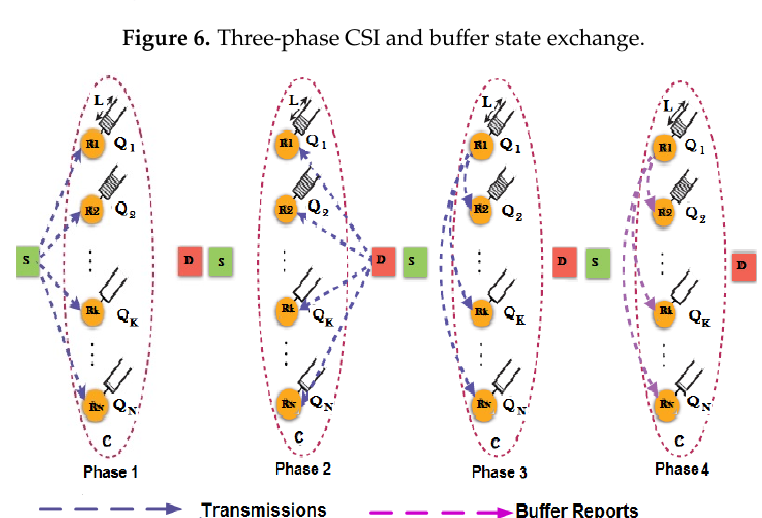
Figure 7. Four-phase CSI and buffer state